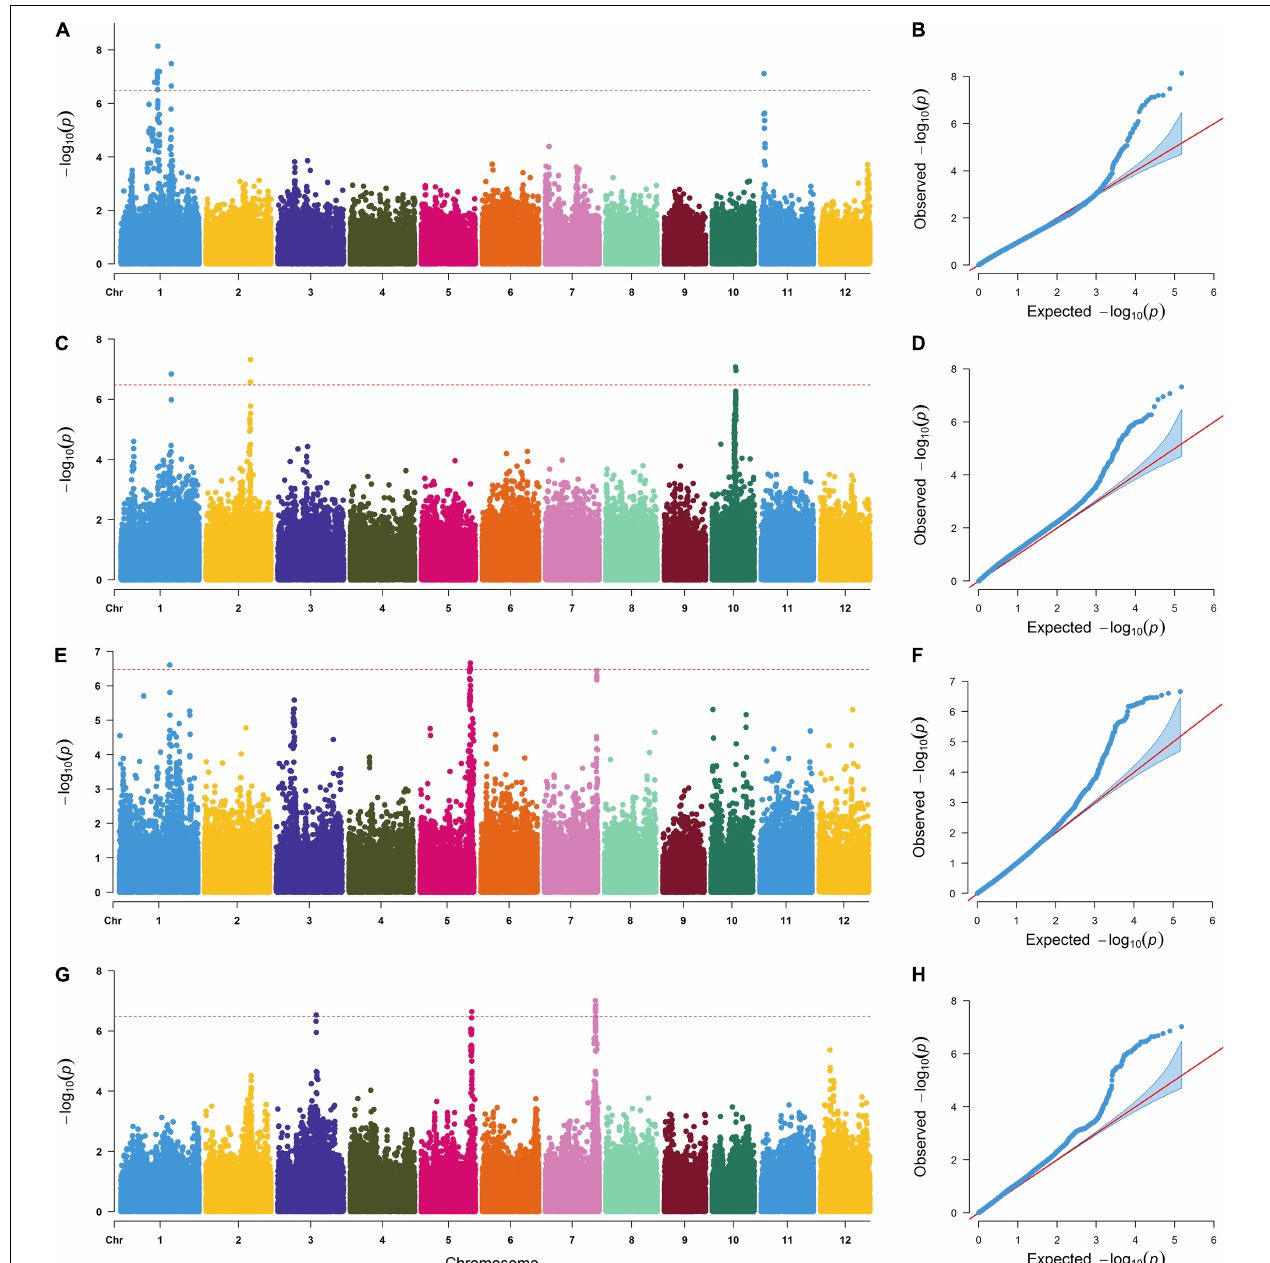
FIGURE 2 | Manhattan plots and quantile–quantile (Q–Q) plots of genome-wide association studies for the LNA, HNA, LNUE, and HNUE. (A) Manhattan plot for the LNA. (B) Q–Q plot for the LNA. (C) Manhattan plot for the HNA. (D) Q–Q plot for the HNA. (E) Manhattan plot for the LNUE. (F) Q–Q plot for the LNUE. (G) Manhattan plot for the HNUE. (H) Q–Q plot for the